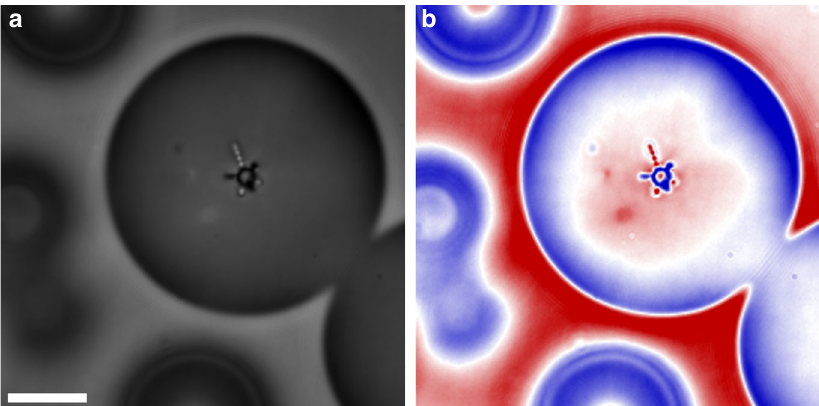
Fig. 6 Octahedral satellite packing. Confocal microscopy image of a radial nematic droplet showing a structure with 6 primary orbit satellites formed by water droplets with normal boundary conditions a and the corresponding color enhanced image b . Scale bar: 10 μ m